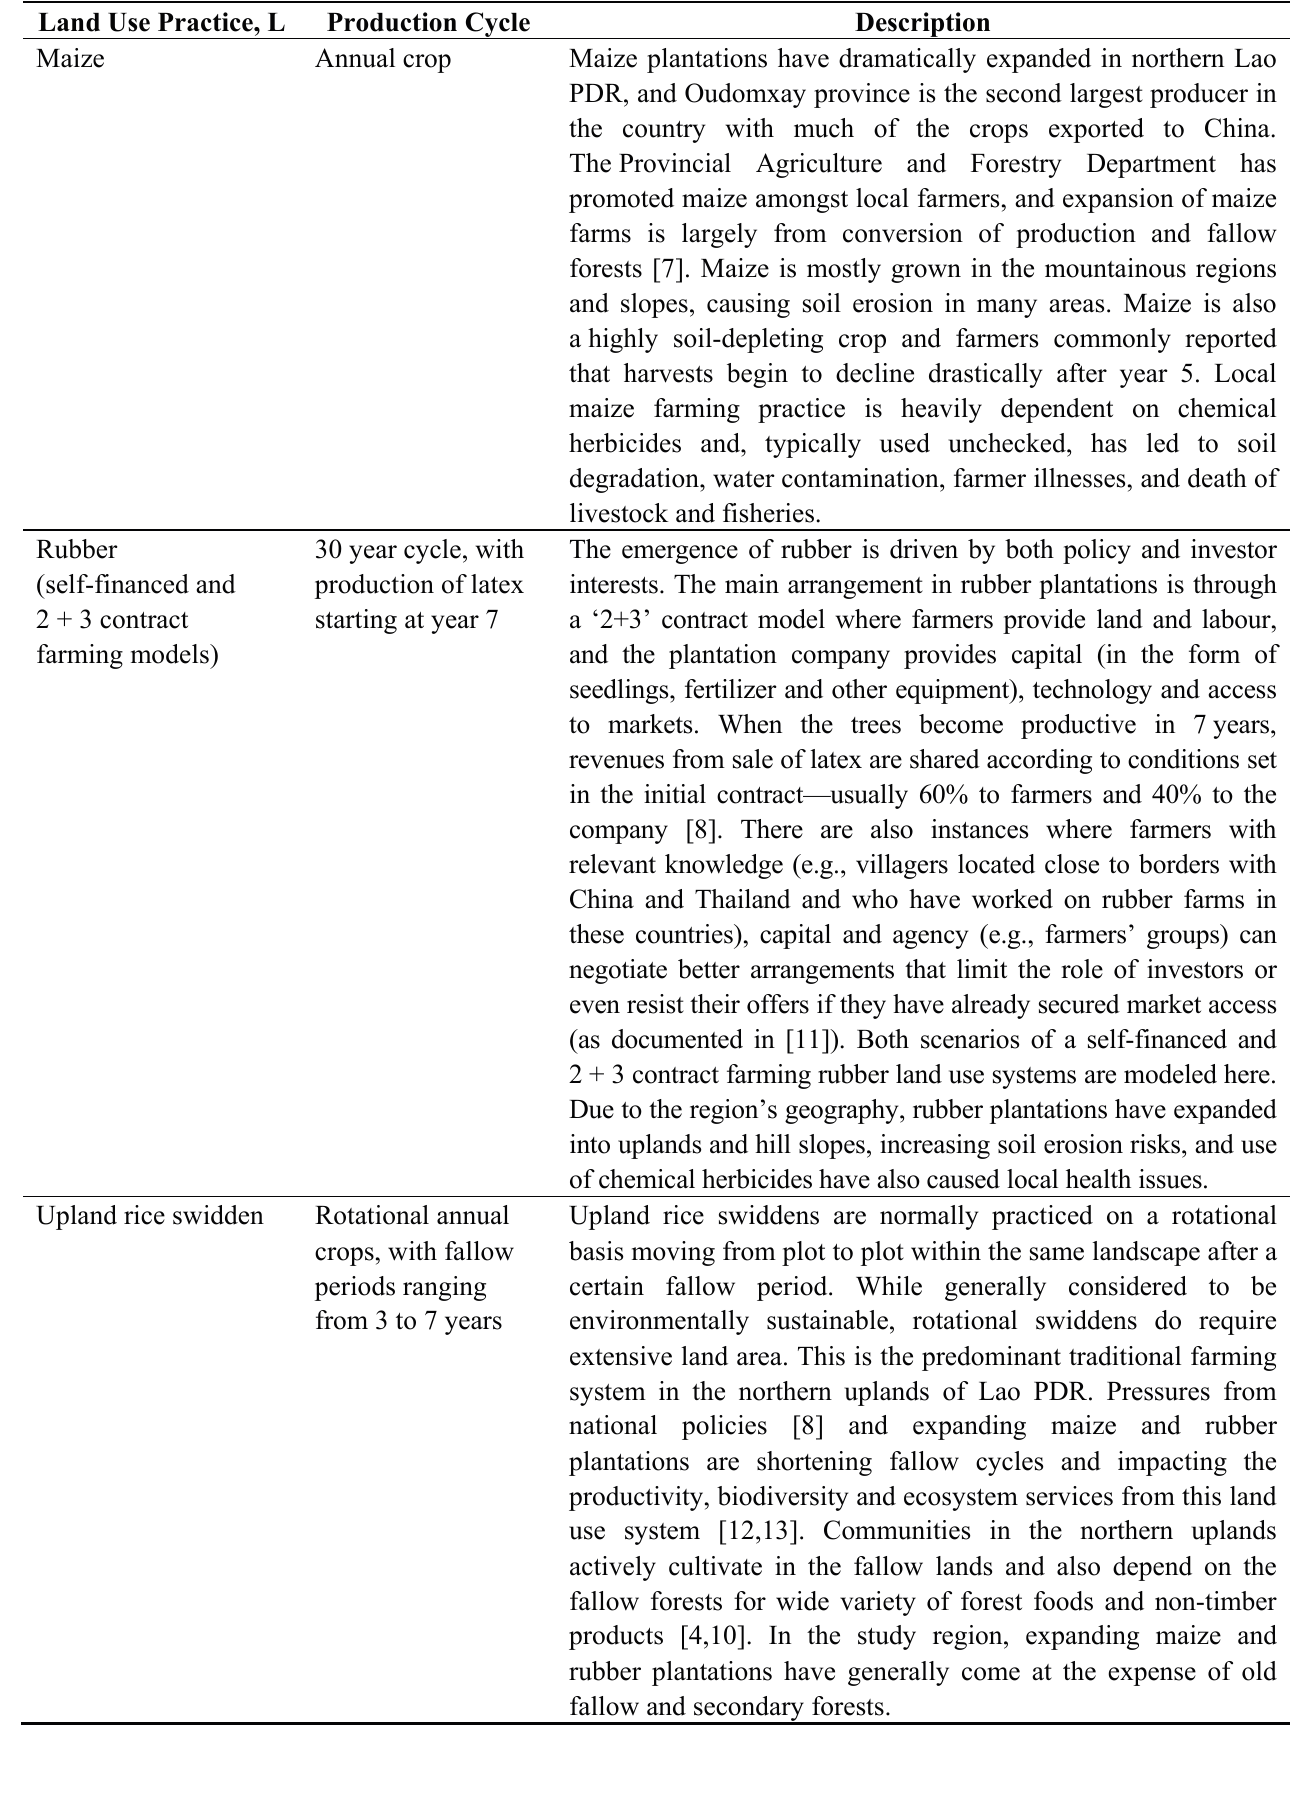
Table 2. Description of the land use practices considered in this